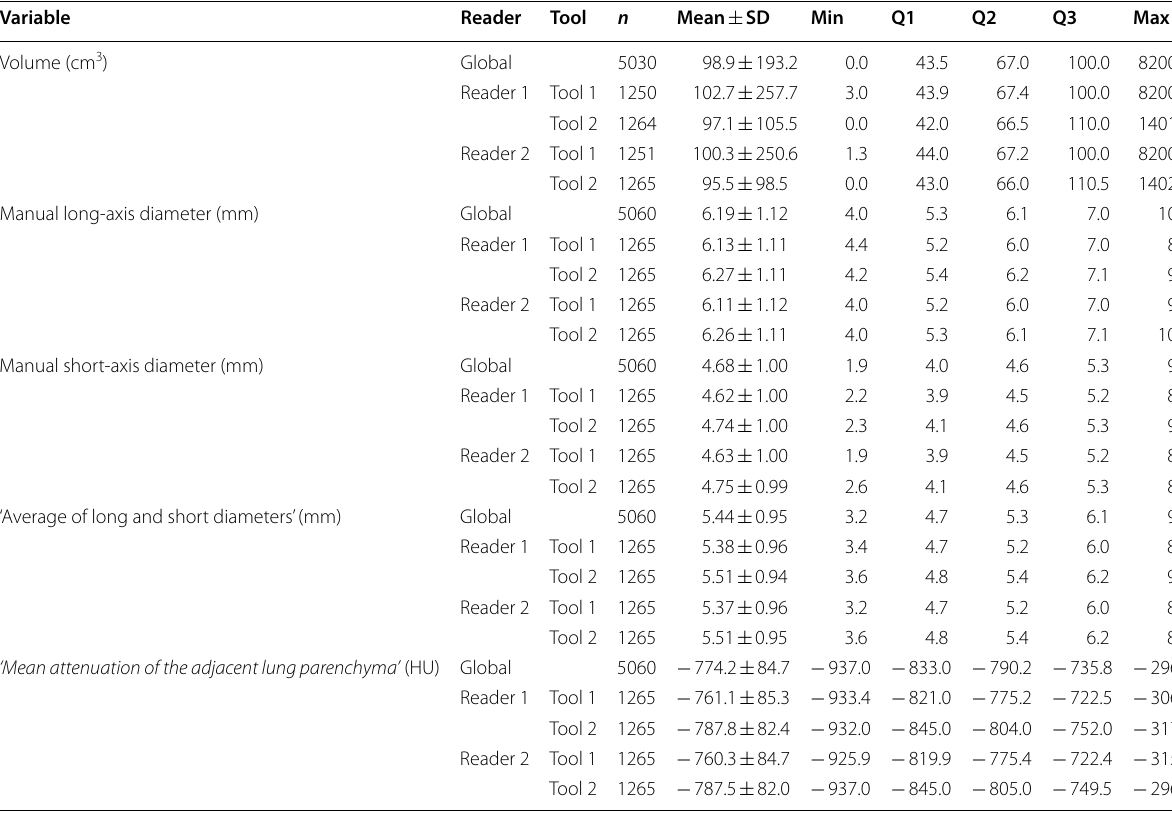
Table 3 Results for quantitative variables